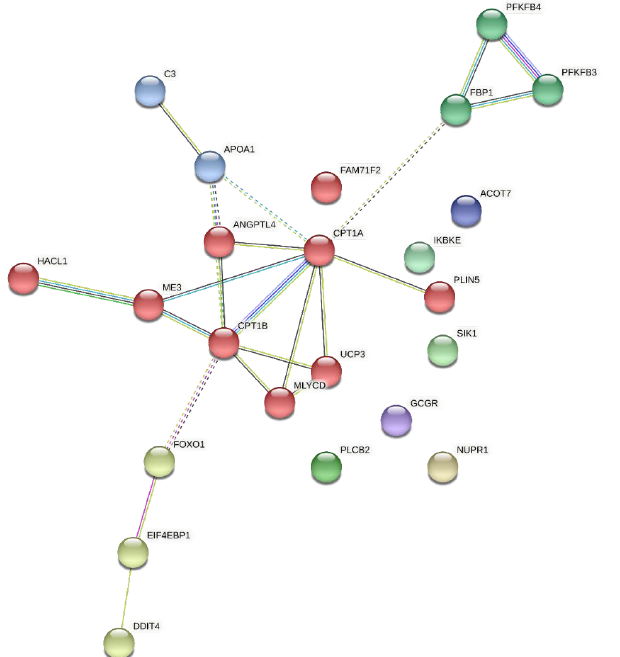
Figure 8. Protein–protein interaction network of DEGs downregulated in G2 that participate in the biological processes and KEGG pathways identified as enriched and highlighted in the G1 × G2 comparison at weaning. Type of interaction (edge color) between nodes (DEGs): light green—text mining; dark green—neighborhood; light blue—curated databases; dark blue—co-occurrence; pink—experiments; purple—protein homology; black—co-expression. A larger number of edges indicate stronger evidence/greater strength of the interaction between two nodes. The nodes that make up the clusters formed (joined by dotted edges) are illustrated with different colors.